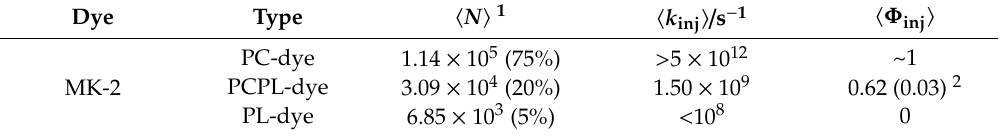
1.0 k / 10 9 s -1 inj Figure 4. ( a ) PL decay curve of MK-2 in a DSSC recorded under local illumination. The solid line corresponds to a double-exponential fit ( χ 2 > 0.98). ( b ) Histograms of the fractional contribution of f 1 and f 2 . Histograms of ( c ) electron injection rate ( k inj ) and ( d ) electron injection yield ( Φ inj ) obtained for 100 local positions in a MK-2-DSSC device.; Table 2. Parameters obtained by photocurrent (PC) and photoluminescence (PL) microscopy. Dye Type (cid:104) N (cid:105) 1 (cid:104) k inj (cid:105) / s − 1 (cid:104) Φ inj